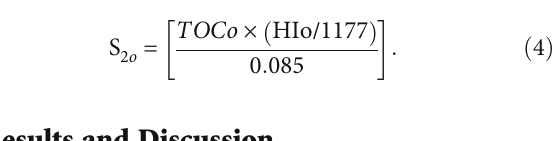
(Figure 10) and TOCo (Figure 11) — were generated for pro- spective shale beds in the Liard Basin. From TOCo volume and Equation (4) [10], the original generation potential ð S Þ of the shale gas beds could be estimated. The potential 2 o value indicated the hydrocarbon content in the rocks; thus,